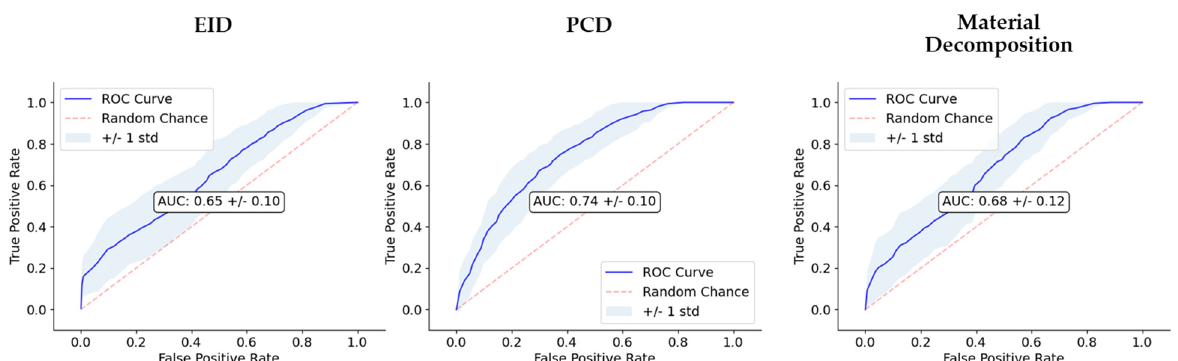
Figure 8. Comparison of classifier performance. We show the receiver operating characteristic (ROC) curves for each of the three image types (EID, PCD, material maps). In the center of the plots, AUC is also reported. The dashed line along the diagonal of the ROC is included as a reference to show how the ROC of a random, no-skill classifier would appear.